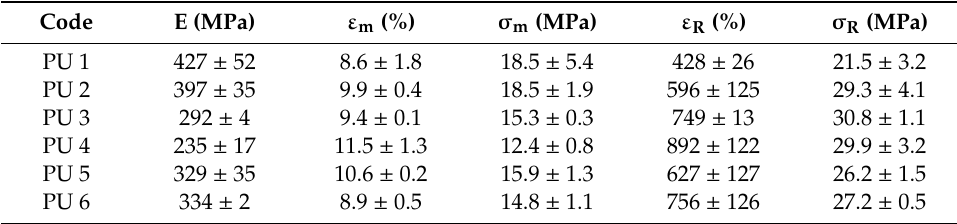
Table 4. Tensile mechanical properties of the PUs (PU 1–6). Designations: E-elastic modulus (Young’s modulus), σ m maximum stress, ε m elongation at the maximum stress, ε R is the ultimate elongation, and σ R is the stress at